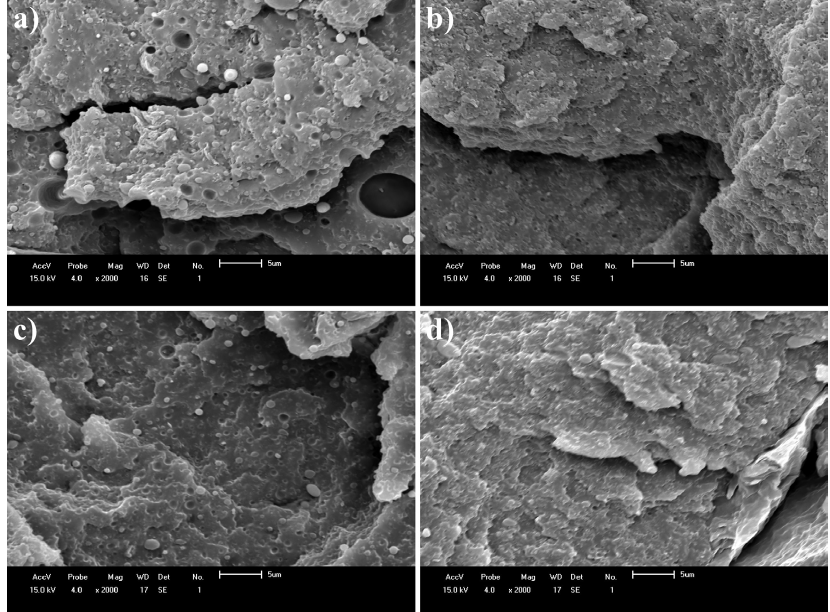
Figure 5. Micrographs of the nanocomposite with 1 reprocessing cycle (a), with 3 reprocessing cycles (b), with 5 reprocessing cycles (c) with 7 reprocessing cycles (d).